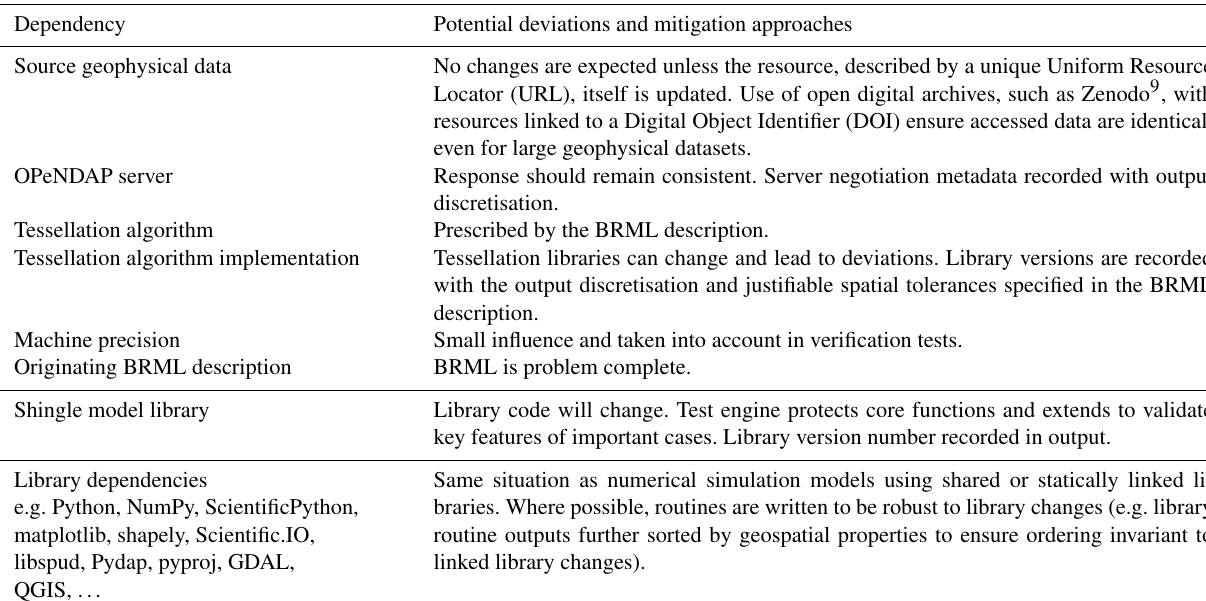
Table 3. Dependencies and sources of potential deviation in the output spatial discretisations. Dependency Potential deviations and mitigation approaches Source geophysical data